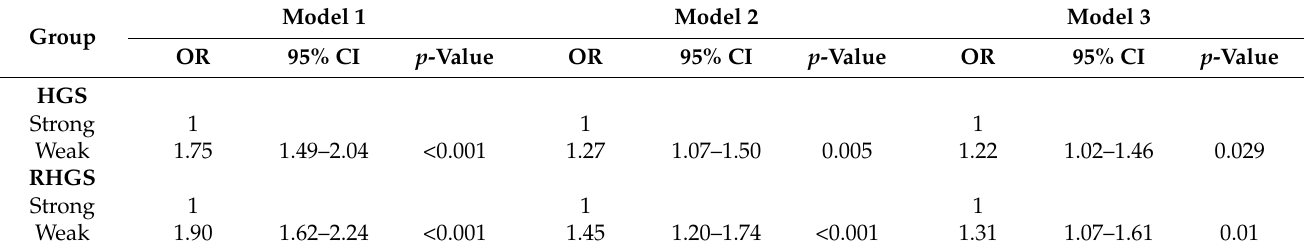
Table 2. Associations between chronic LBP and HGS and RHGS according to multiple logistic regression.